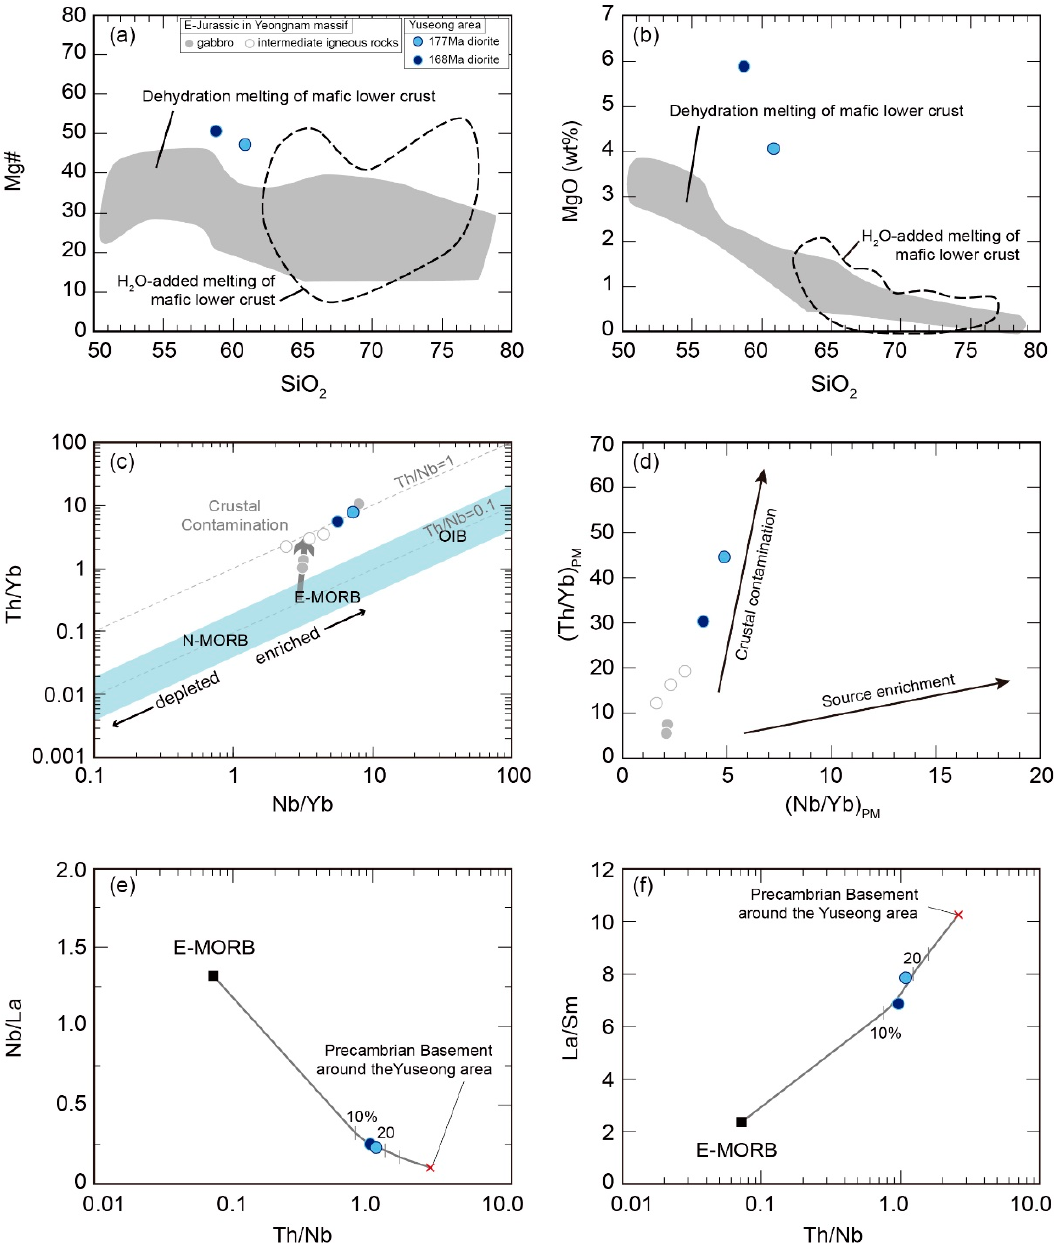
Figure 7. Binary plots for the Jurassic diorite in the Yuseong area and the Early Jurassic gabbro and intermediate igneous rocks in the YM in the ( a ) Mg# vs. SiO 2 , ( b ) MgO vs. SiO 2 (after Lu et al. [47]), ( c ) Th/Yb vs. Nb/Yb, (after Green [38]) ( d ) (Th/Yb) PM vs. (Nb/Yb) PM (after Jowitt and Ernst [48]), ( e ) Nb/La vs. Th/Nb, and ( f ) La/Sm vs. Th/Nb diagrams. The (Th/Yb) PM vs. (Nb/Yb) PM diagram is used to investigate whether magma un- derwent crustal contamination or source enrichment [48]. Distinctly higher (Th/Yb) PM values than (Nb/Yb) PM values ((Th/Yb) PM = 30.5–44.3, (Nb/Yb) PM = 3.7–4.8) in the diorite indicate that the enrichment occurred due to crustal contamination during magma ascent (Figure 7d). In the Th/Yb vs. Nb/Yb diagram (Figure 7c), the Jurassic diorite plots above the MORB array, with high Th/Yb ratios of 5.5–8.0, which also supports the significant crustal contamination of source magma. Additionally, the existence of inherited